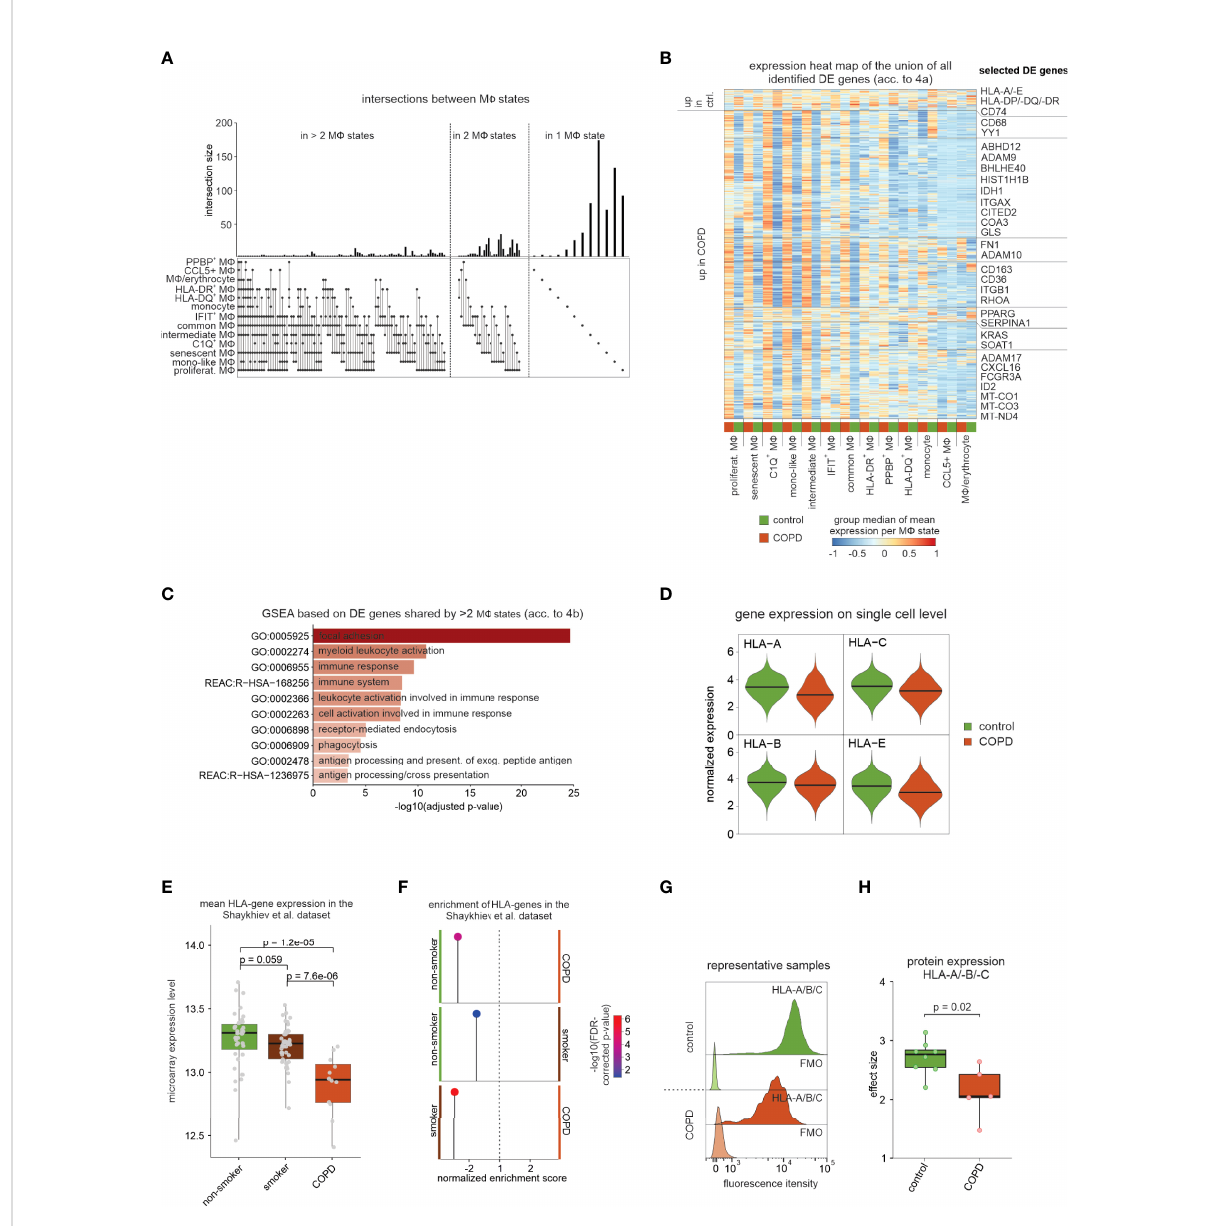
FIGURE 4 DE gene analysis of identi fi ed macrophage states. (A) UpSet plot of calculated DE genes across macrophage states. DE genes found in the same states are binned and the size of the bins is represented as a bar chart. At the bottom, dots indicate which macrophage states contained and shared these DE genes. (B) Heat map representation of the union of all DE genes found in the macrophage states. Depicted is the group median (group = COPD or control) of the z-transformed mean expression data per donor and macrophage state across all macrophage states, and the names of some selected DE genes are shown on the right side of the plot. Columns and rows of the heat map are sorted by hierarchical clustering. (C) Selected functional gene sets from GSEA based on DE genes that reach the de fi ned signi fi cance cutoffs for more than two macrophage states (acc. to Figure 4B). (D) Violin plot with marked median of HLA-A/-B/-C and -E expression in all macrophages based on scRNA-seq data. The plot shows the expression across the donors, whereby the donors were downsampled to the same number of cells, followed by downsampling to the same number of cells between COPD and control. The plot displays cells with an expression > 0. (E) Box plots (with marked median values) showing the mean expression per sample of HLA genes expressed in macrophages (error bars indicating the standard deviation; statistics are based on the Wilcoxon rank sum test). The data are obtained from Shaykhiev et al. (17). (F) Pin plot representing the enrichments in the samples of Shaykhiev et al. of HLA genes expressed in macrophages. (G) Fluorescence intensity histograms showing representative samples of fl ow cytometric analysis of HLA-A/-B/-C expression on the cell surface of isolated macrophages (FMO = fl uorescence minus one). (H) Box plots with marked median of the calculated effect sizes of HLA-A/-B/-C expression in COPD and control with the representation of individual donors (control n = 8, COPD n = 5; error bars indicating the standard deviation; statistics based on Wilcoxon rank sum test). M Ф , macrophage; mono, monocyte; DE, differentially expressed; GSEA, gene set enrichment analysis; FDR, false discovery rate; FMO, fl uorescence minus